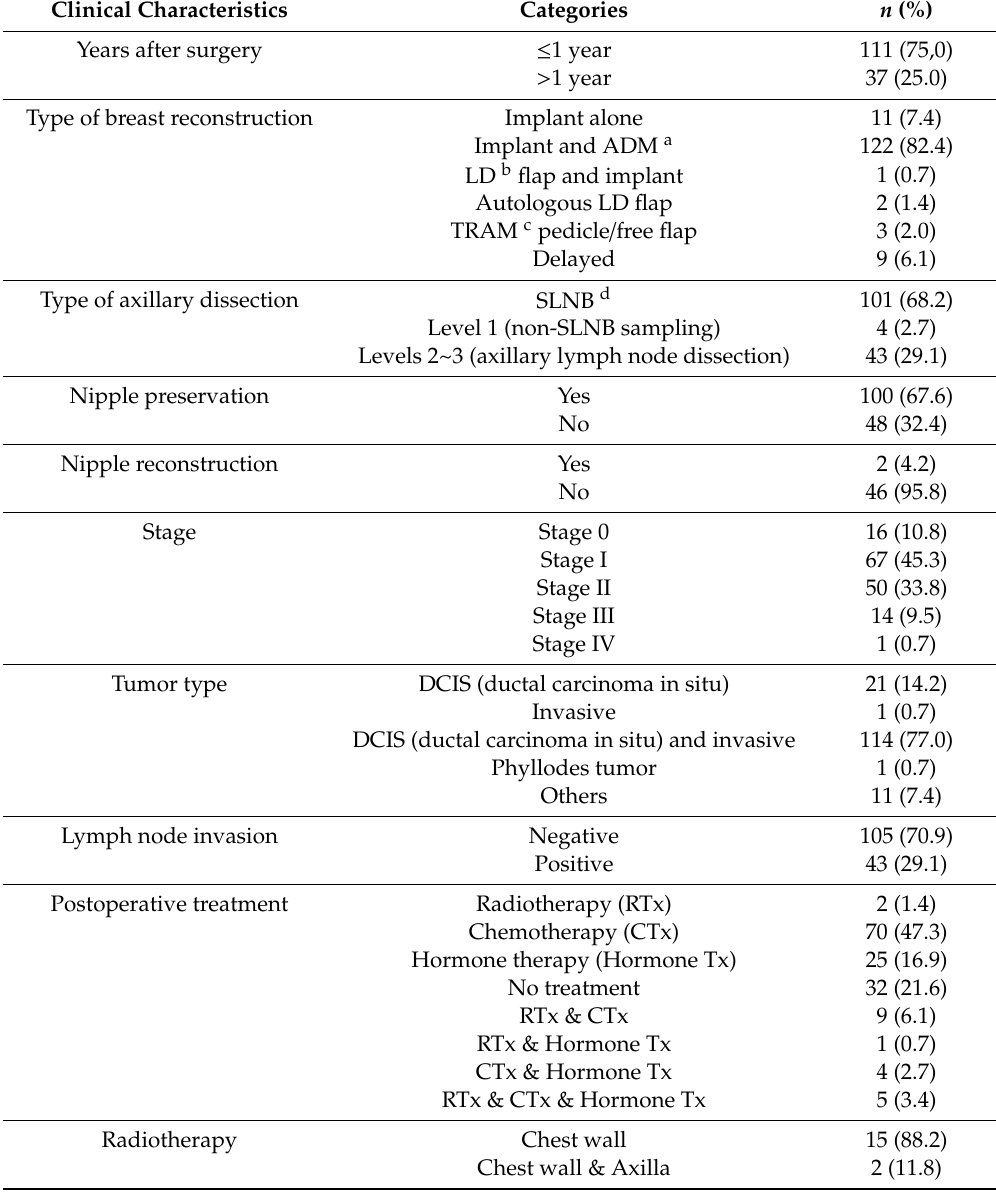
Table 2. Clinical characteristics of participants ( n =